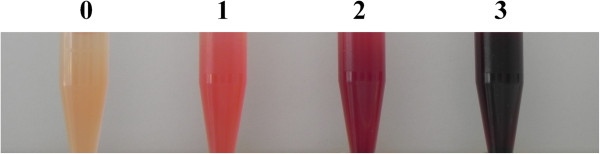
Typical appearance of thawed serum samples and attributed hemolysis scores. 0 = clean and transparent; 1 = mildly hemolytic, transparent; 2 = moderately hemolytic, decreased transparency; 3 = severely hemolytic and opaque.